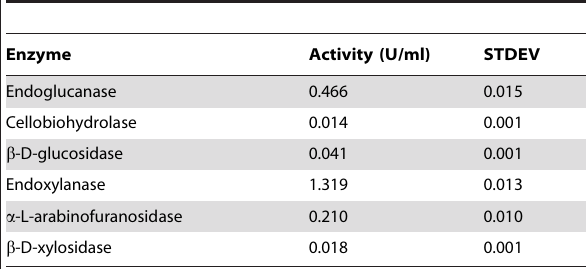
Table 1. Glycoside hydrolase activities produced by the thermophilic